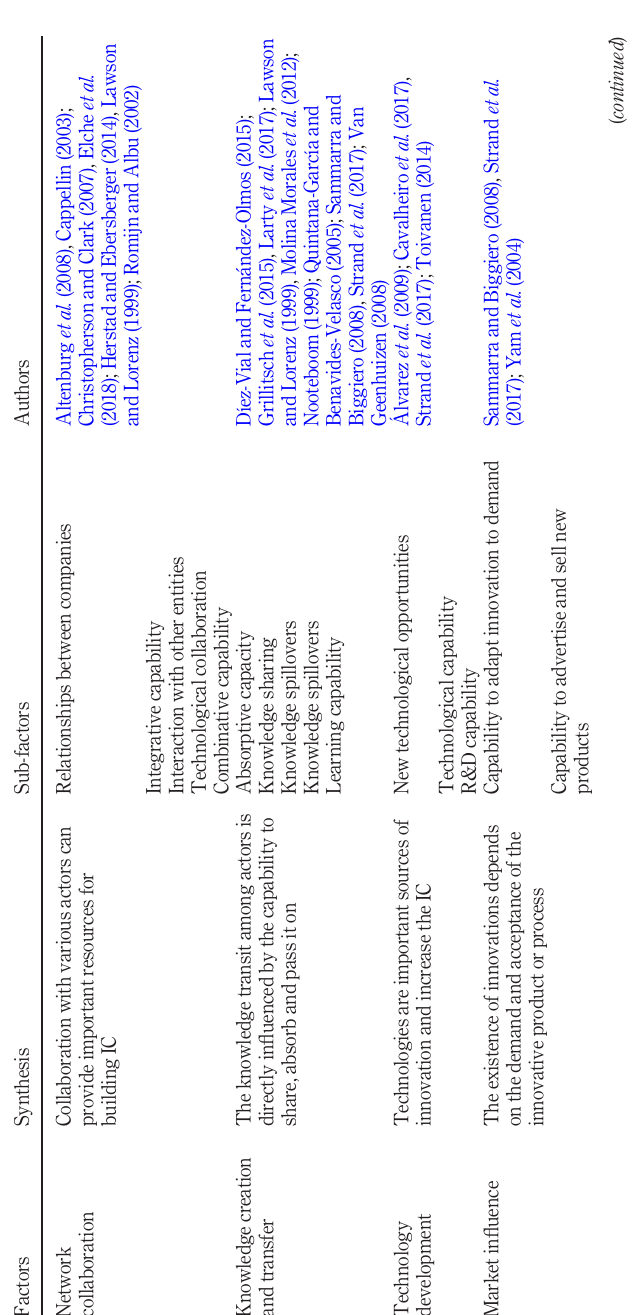
Table 7. Factors and sub- factors related to